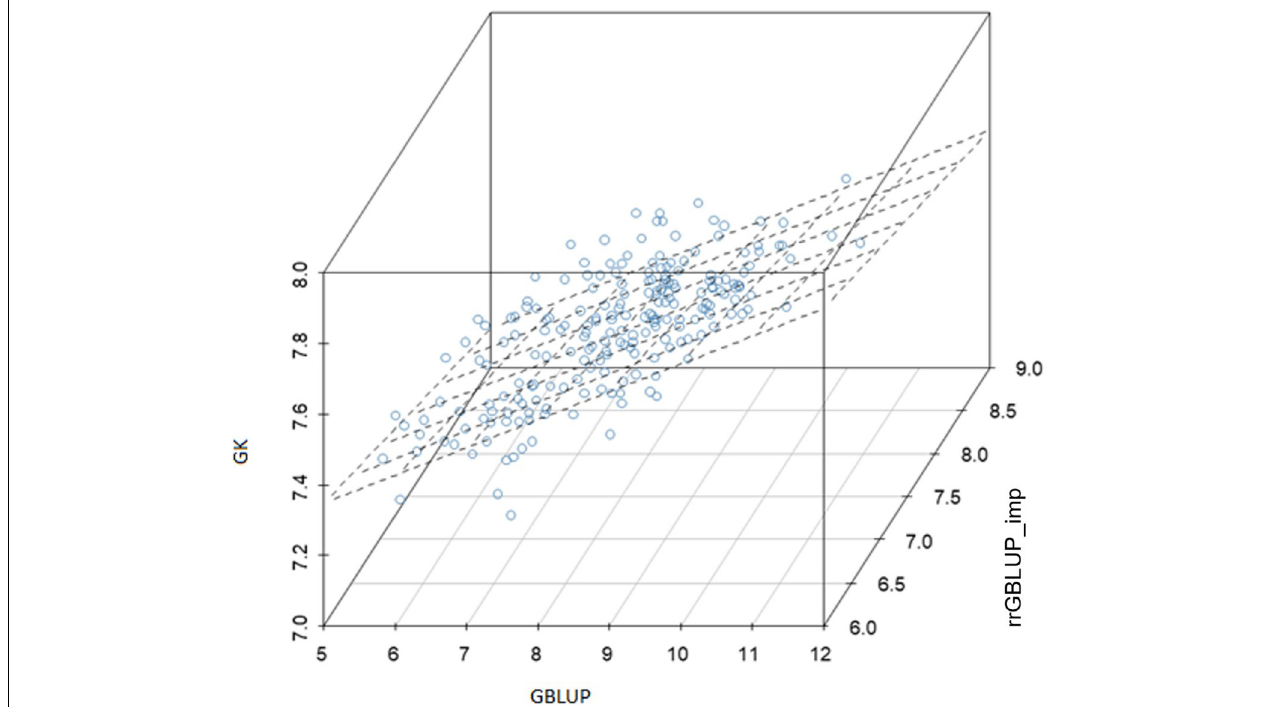
FIGURE 6 | Experiment 2: Relationship between genomic-enabled predictive values of 213 F2 which were later advanced to F4 (F2:4) using models GK, GBLUP, and rrGBLUP_imp. GBLUP, genomic best linear unbiased prediction; rrGBLUP, Ridge Regression BLUP; GK, Gaussian